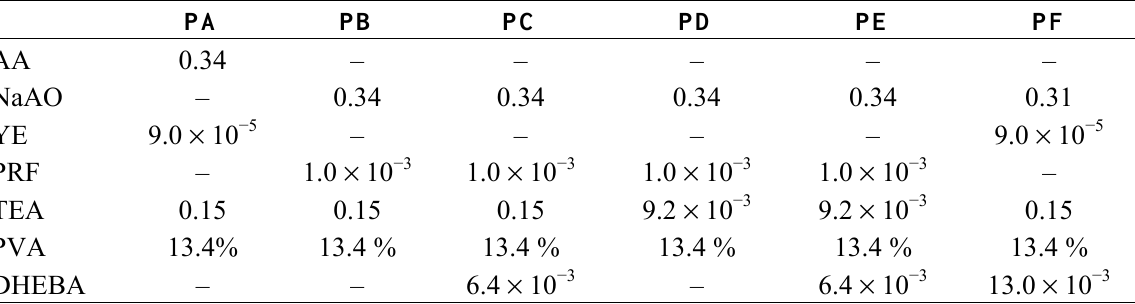
Table 1. Composition of the prepolymer solution in molarity, poly (vinyl alcohol) (PVA) in